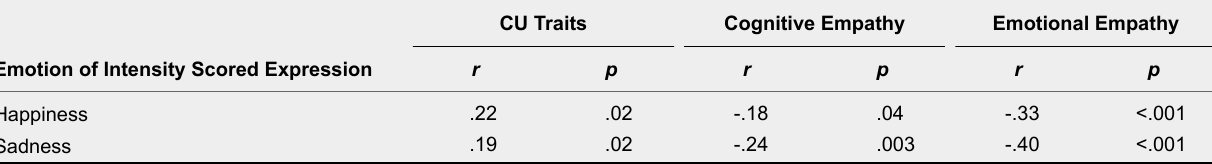
Correlations Between the SAM Intensity Scores for Emotional Expressions and the Self-Report Measures of CU Traits and Empathy CU Traits Cognitive Empathy Emotional Empathy Emotion of Intensity Scored Expression r p r p r p Happiness .22 .02 -.18 .04 -.33 <.001 Sadness .19 .02 -.24 .003 -.40 <.001 Note. Lower scores indicate more intense